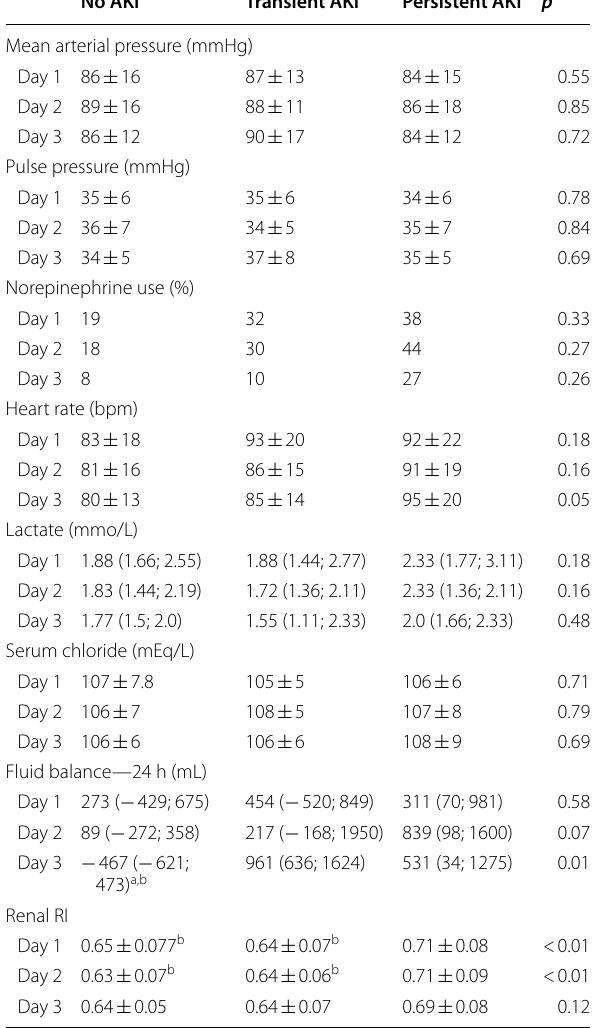
Table 2 Hemodynamic and laboratorial data according to acute kidney injury category